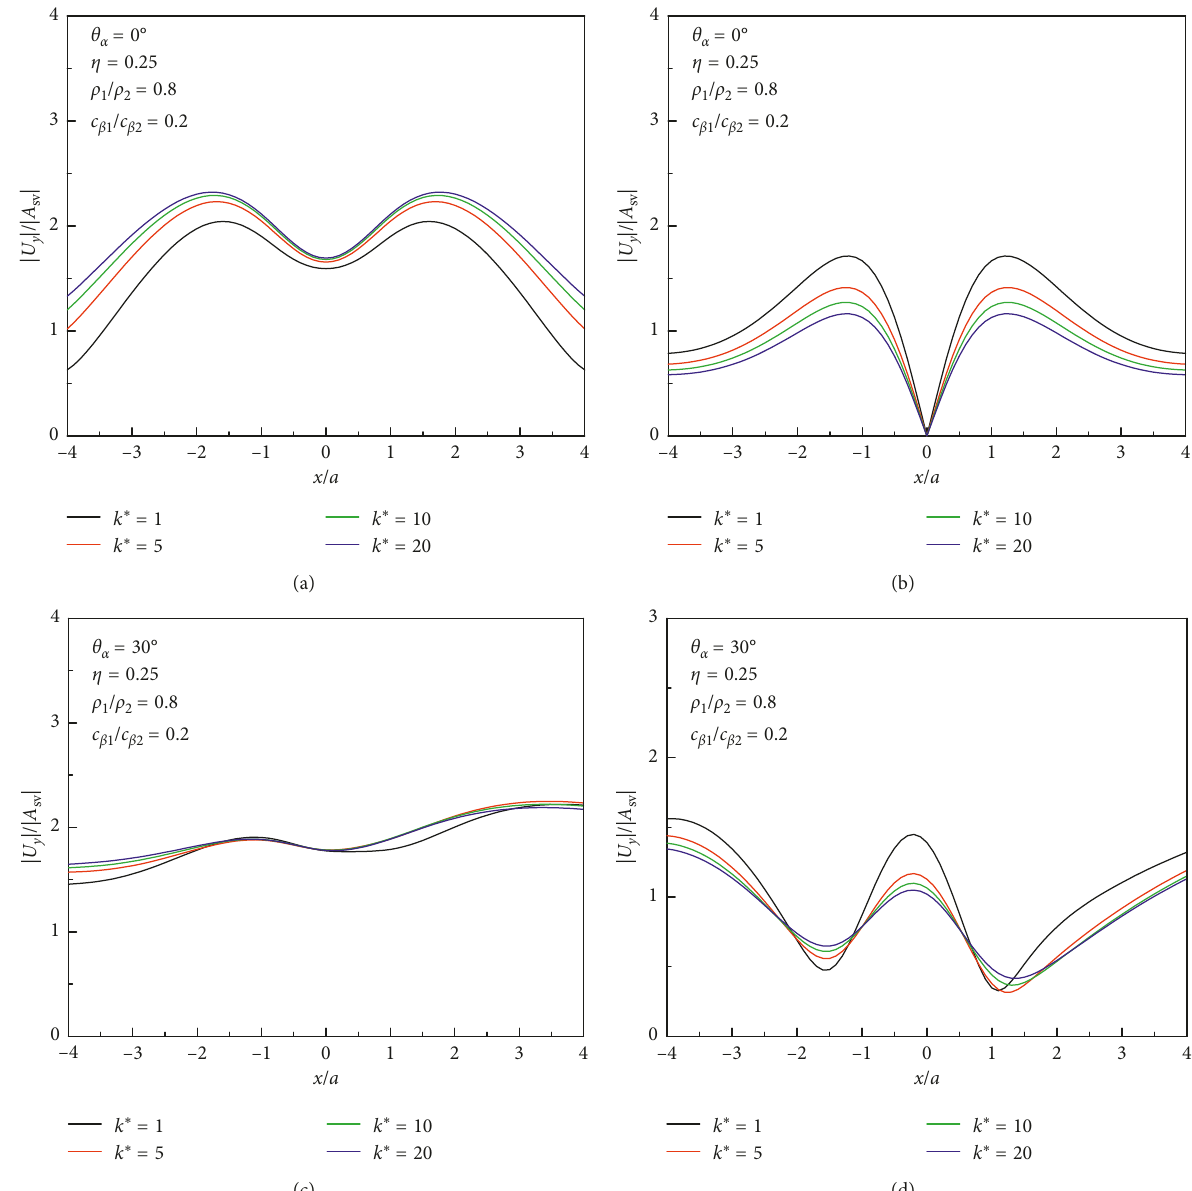
Figure 11: Surface displacement amplitudes near tunnel lining under the incident SV wave ( η amplitude; (b) surface vertical displacement amplitude; (c) surface horizontal displacement amplitude; (d) surface vertical displacement